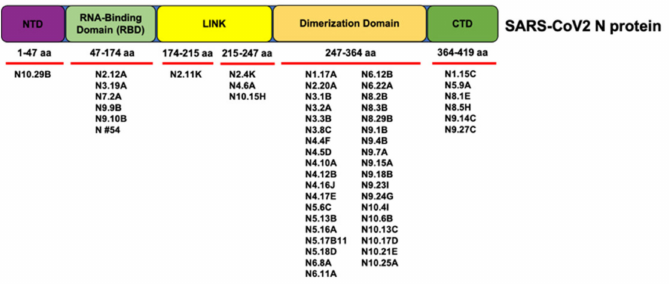
Figure 3. Schematic depicting the regions of the N protein targeted by each antibody based on competitive ELISA